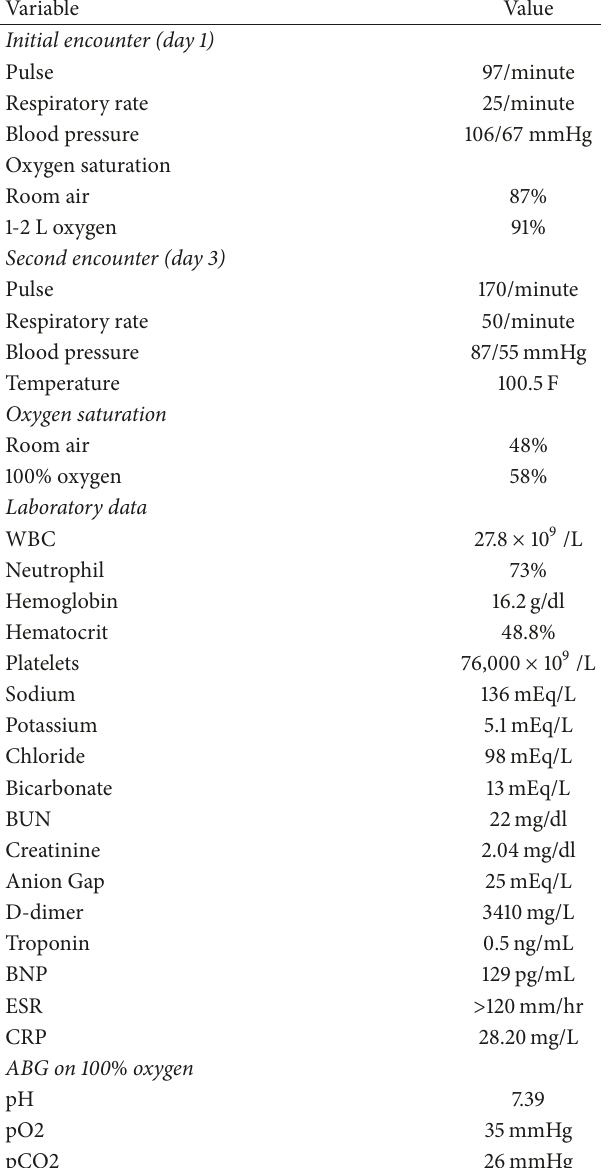
Table 1: Patient characteristics.